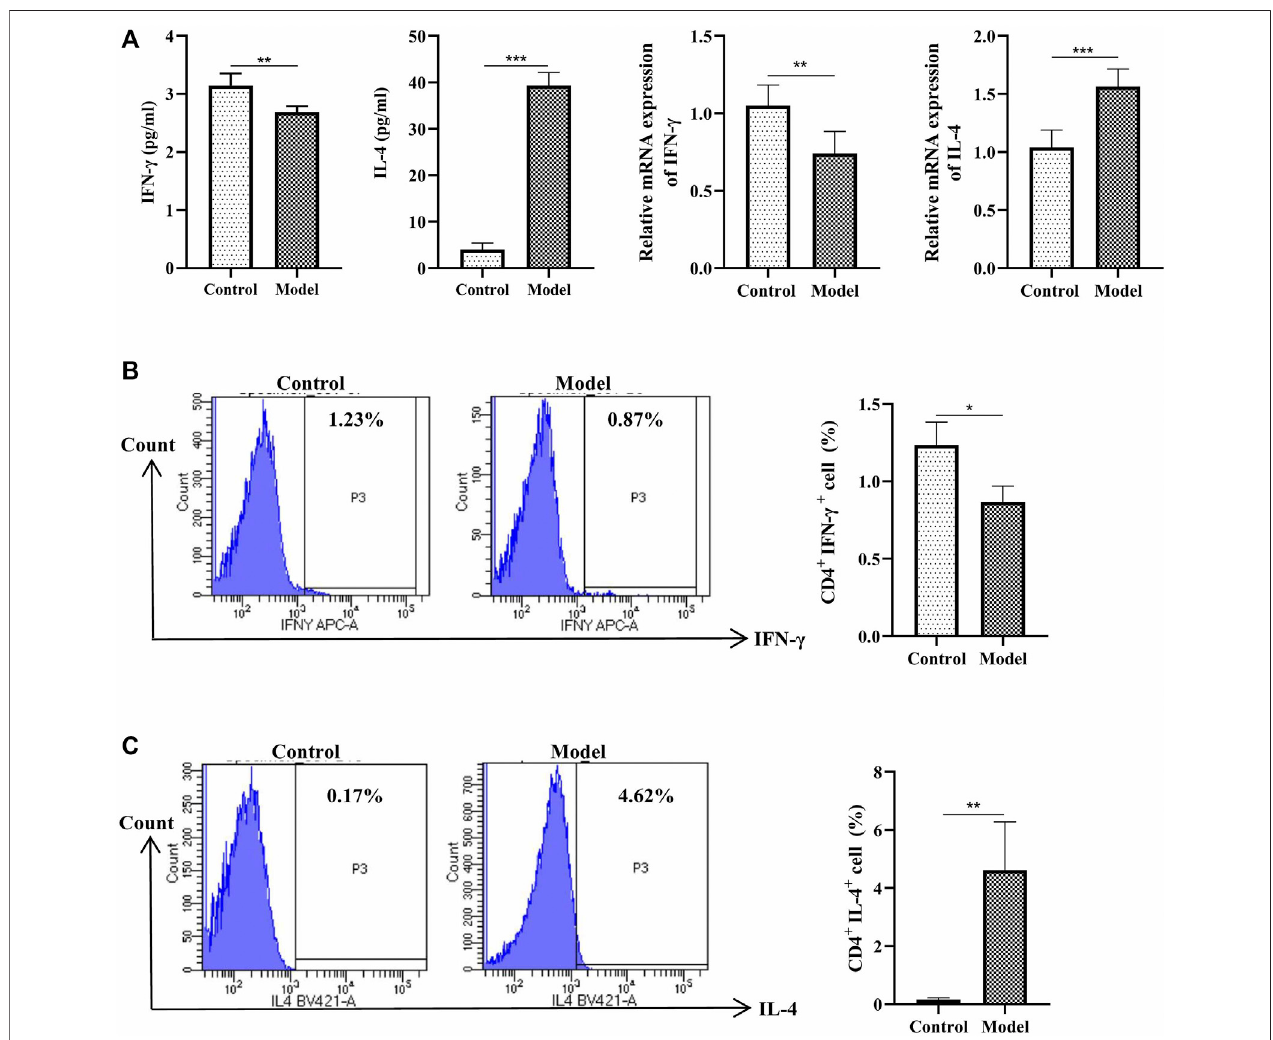
FIGURE2| DetectionofTh1andTh2cells. (A) Left:DetectionofIFN- γ ,IL-4inBALF,BALFwascollected24 hafterlastchallenge,theyweredetectedasdescribed in the protocol; Right: Relative expression ofIFN- γ mRNA and IL-4 mRNA detected byRT-qPCR (B) Left: Intracellular staining of CD4 and IFN- γ in the door CD3 + T cells 24 h after last challenge; Right:Statistic data of Th1 cells 24 h after challenge; (C) Left: Intracellular staining of IL-4 and CD4 in the door CD3 + T cells 24 h after last challenge; Right: Statistic data of Th2 cells 24 h after challenge. * p < 0.05, ** p < 0.01, *** p ≤ 0.001. All the values are expressed as mean±SEM. n = 5 animals per